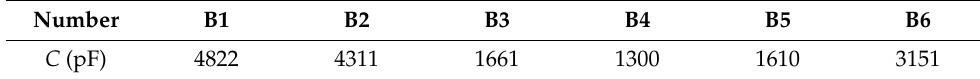
Table 8. Changes in C with modulus.